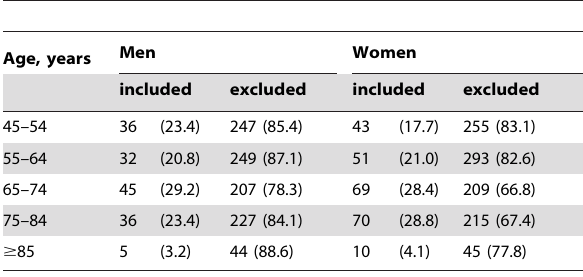
Table 2. Age distribution of the combined sample from KORA-F4L and